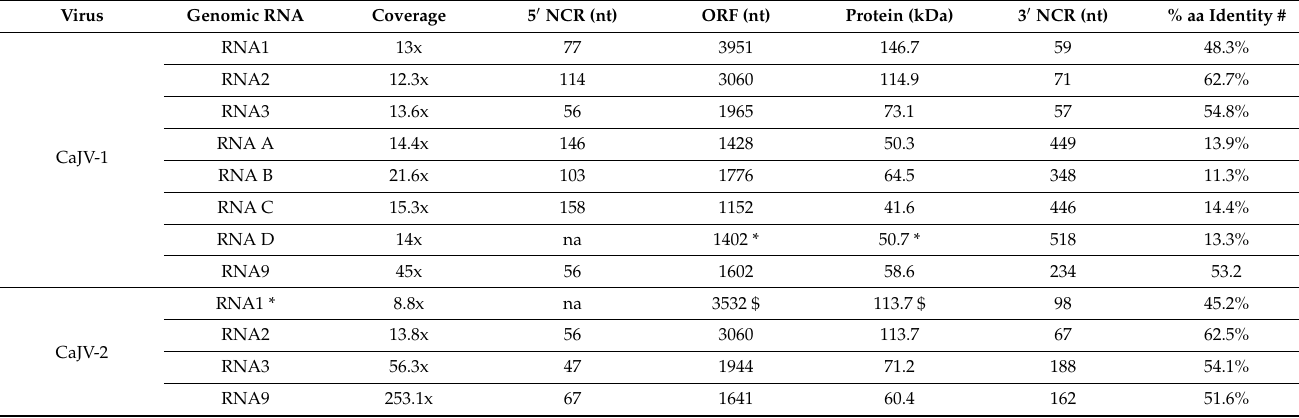
Table 3. Genome organization and properties of the contigs or scaffolds identified for CaJV-1 and CaJV-2 from public pecan